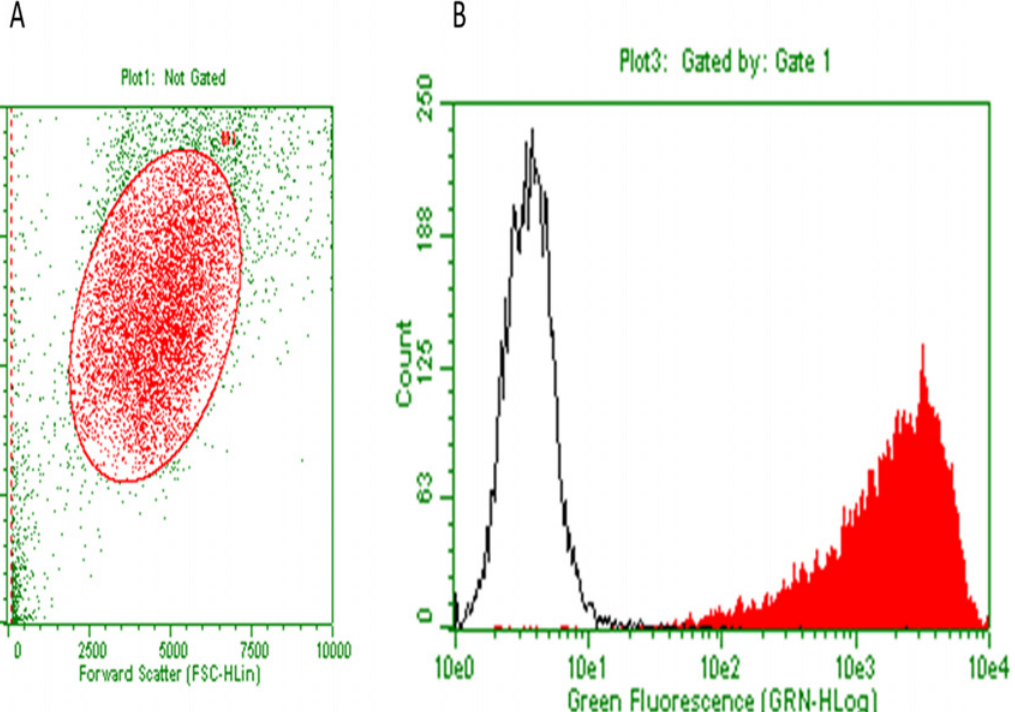
Fig 1. Staining of BxPC-3 cells with anti-CEA antibody and quantification of binding sites. BxPC-3 cells were treated with anti-CEA antibody and stained with a fluorochrome conjugated secondary antibody against anti-CEA (red, filled), or control-stained with secondary antibody only (black, open) and analyzed by flow cytometry. Gating was for the main population (A). The anti-CEA antibody binding capacity, determined with reference beads, was very high (2,227,000 binding sites per cell)